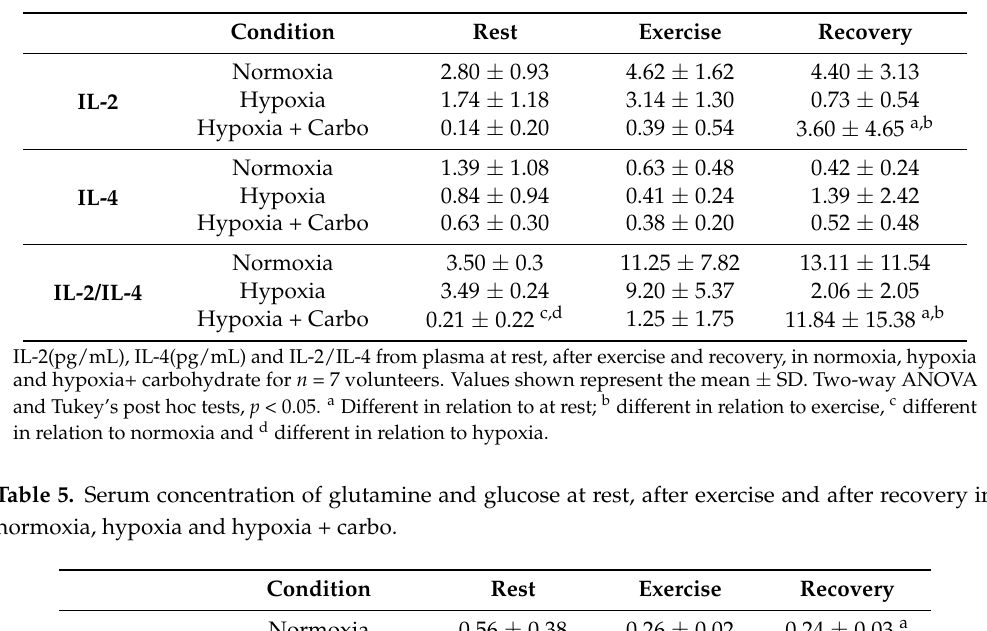
Table 4. Serum concentrations of IL-4, IL-2/IL-4 and IL-2 at rest, after exercise and after recovery in normoxia, hypoxia and hypoxia + carbo.